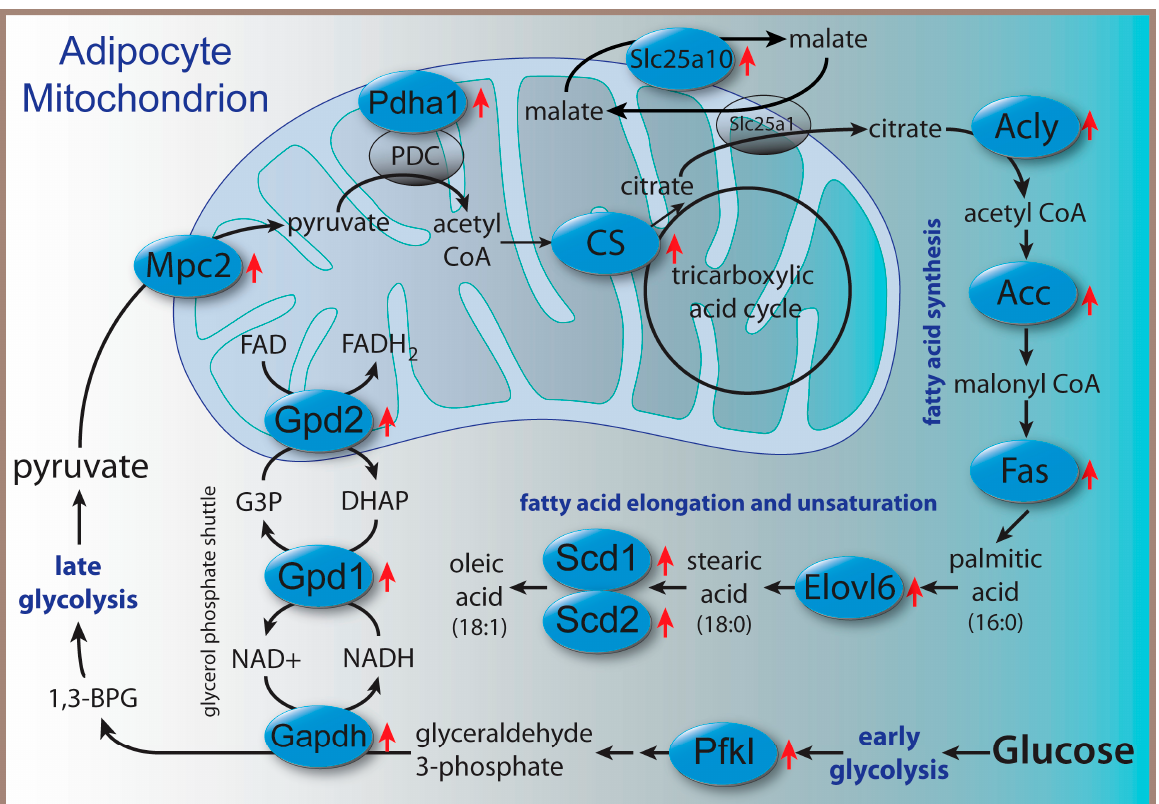
Figure 1. Schematic of major gene expression increases observed in adipose tissue associated with glucose utilization for lipid synthesis in Acss2 − / − mice. Proteins whose genes showed significant upregulation are indicated by red arrows. Despite the increased expression of lipogenic genes, only myristic acid (C14:0) was increased in abundance in adipose tissue. Abbreviations: 1,3-BPG = 1,3- bisphosphoglycerate, ACC = acetyl CoA carboxylase, Acly: ATP citrate lyase, CS = citrate synthase, DHAP = dihydroxyacetone phosphate, Elovl6 = fatty acid elongase 6, Fas = fatty acid synthase, G3P = glycerol 3-phosphate, Gapdh = glyceraldehyde 3-dehydrogenase, Gpd1 and 2 = glycerol 3-phosphate dehydrogenases 1 (cytoplasmic) and 2 (mitochondrial), Mpc2 = mitochondrial pyruvate carrier 2, Pdah1 = pyruvate dehydrogenase E1 alpha 1, PDC = pyruvate dehydrogenase complex, Pfkl = phosphofructokinase, liver, Scd1 and Scd2 = stearoyl-CoA desaturases 1 and 2, Slc25a1 = solute carrier family 25, member 1 (citrate carrier), Slc25a10 = solute carrier family 25, member 10.